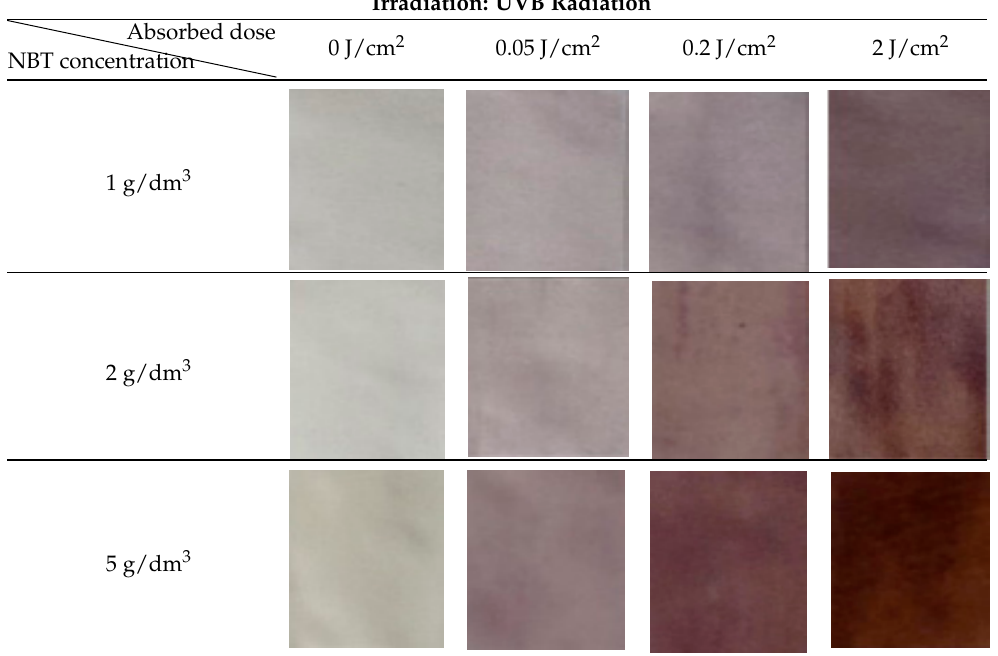
Printing Paste: NBT-Pluronic F-127 Hydrogels Containing Various Concentrations of NBT